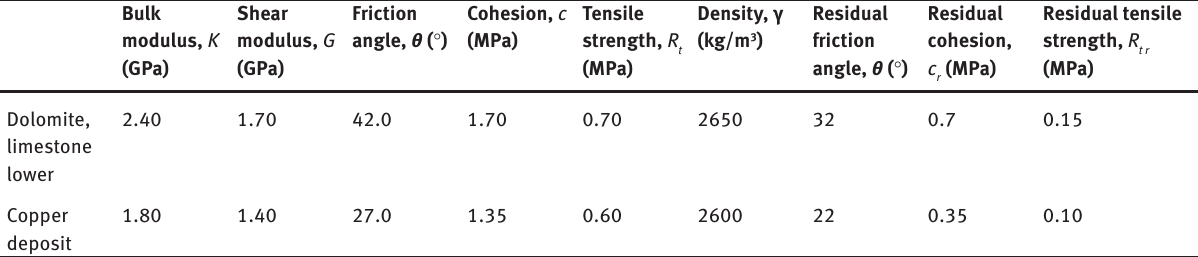
Table 5: Mechanical parameters of rocks for the strain-softening model.